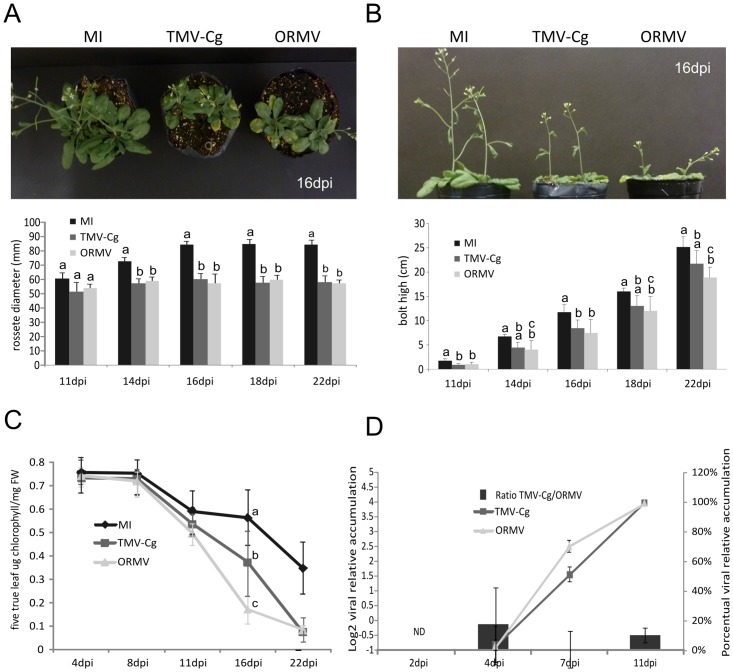
Phenotypic measurements and viral accumulation of two tobamoviruses infecting Arabiodopsis.(A) Arabidopsis thaliana Col 0 rosette at 16dpi and rosette diameter measurements of mock-inoculated (MI) and Oilseed rape mosaic virus (ORMV) or crucifer-infecting Tobacco mosaic virus (TMV-Cg) infected plants. (B) Arabidopsis thaliana Col0 bolt at 16dpi and bolt height measurements of mock-inoculated (MI) and TMV-Cg or ORMV infected plants. (C) Comparative progression of senescence measured as total chlorophylls content in MI, TMV-Cg and ORMV infected plants. Pigments were extracted from individual samples of only five true leaves (D) Ratio of viral loads between TMV-Cg and ORMV inoculated plants at four different dpi using tobamovirus replicase specific qPCR (Bars Graph). Relative (%) level of TMV-Cg and ORMV accumulation along the assay (Lines graph). 11dpi was arbitrary set as 100%. One-way ANOVA with Tukey’s post-test were performed. Different letters above the bars represent significant differences among groups, p-values ≤ 0.05. Error bars represent SE. * = 0.01≤p≤0.05.